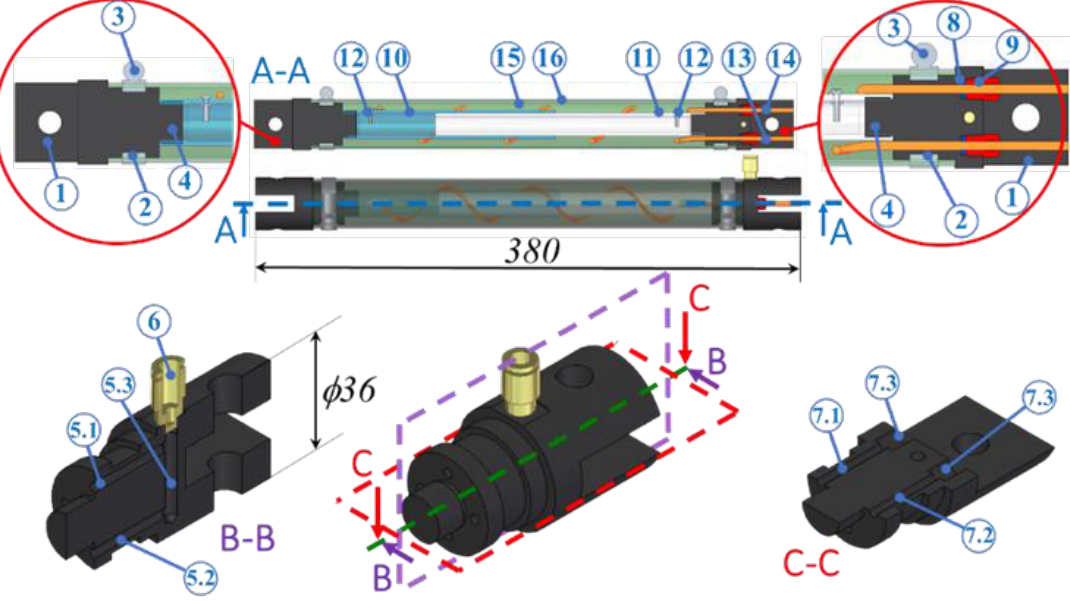
Figure 6. Section views of the designed MKM and section isometric views of the complex end.